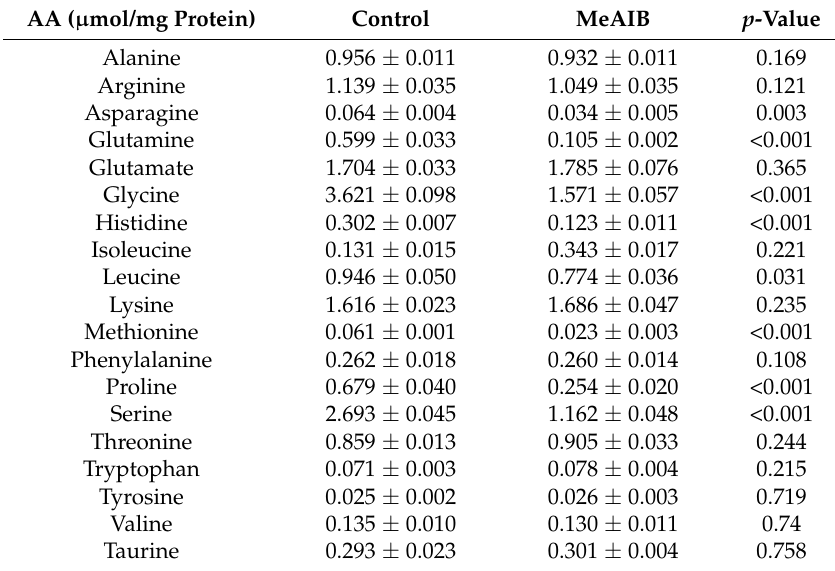
Figure 3. Effect of IPEC-J2 cells’ incubation with MeAIB on protein synthesis ( A ) and degradation ( B ). Protein synthesis (nmol Phe/mg) and protein degradation (%) measured using (3H) labeled phenylalanine. Data are expressed as mean ± S, n = 4 independent experiments. * p < 0.05 versus control treatment. Table 1. Intracellular free amino acid profile of IPEC-J2.